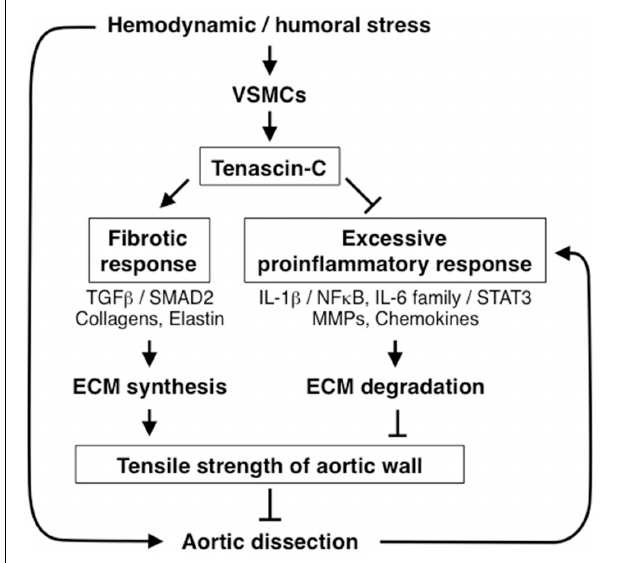
FIGURE 5 | Role of TNC in protection of aortic tissue. Diagram of the role of TNC in the stress response of aortic tissue. Hemodynamic and humoral stress induces TNC expression by vascular smooth muscle cells (VSMCs). TNC, in turn, maintains the fibrotic response and ameliorates the excessive proinflammatory response to reinforce the tensile strength of the aortic wall, thus preventing AAD